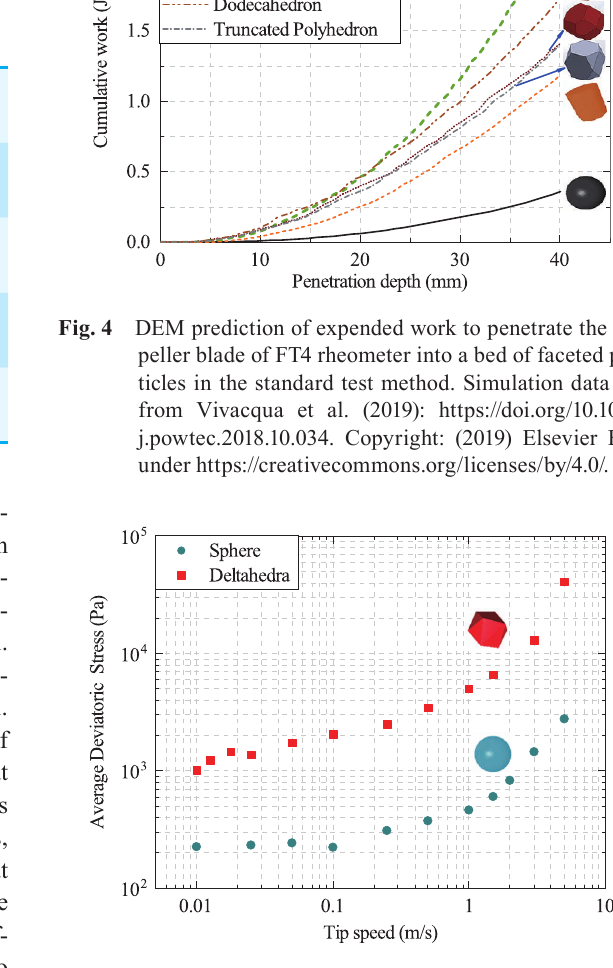
Fig. 5 DEM prediction of shear stress on the impeller blade of FT4 rheometer as a function of impeller blade tip speed for spherical and deltahedra shape particles. Simulation data are from Vivacqua et al. (2019):